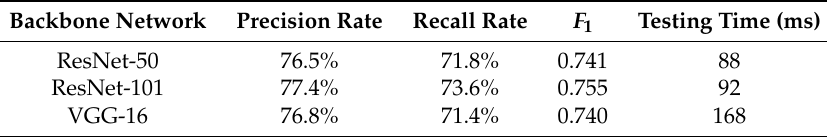
Table 4. Detection performance with different backbone